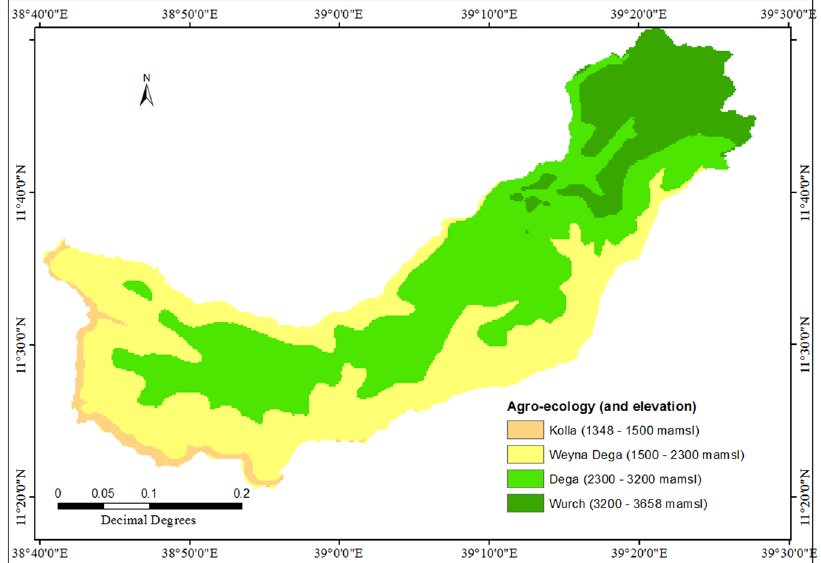
Fig. 2 Agro-ecology and elevation of study districts. The map is generated by Geographical Information System (GIS) based 30 m resolution digital elevation data analysis using Digital Terrain Model